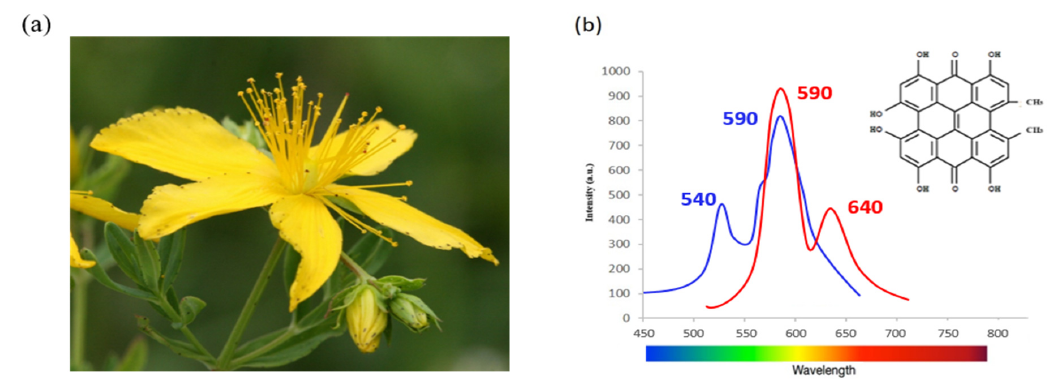
Figure 4. St. John’s wort ( a ). Reproduced with permission of photographer [55]; molecular structure of hypericin and the fluorescence spectrum of hypericin ( b ).